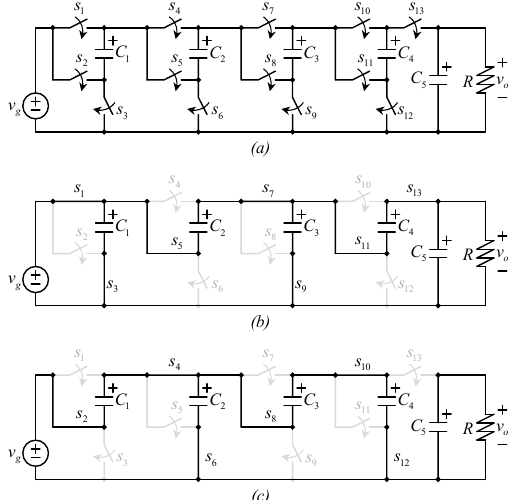
Figure 11. The Fibonacci Converter is another possible extension to the circuit in Figure 9, ( a ) topology, ( b ) equivalent circuit when the single firing signal is high, and ( c ) equivalent circuit when the single firing signal is low.